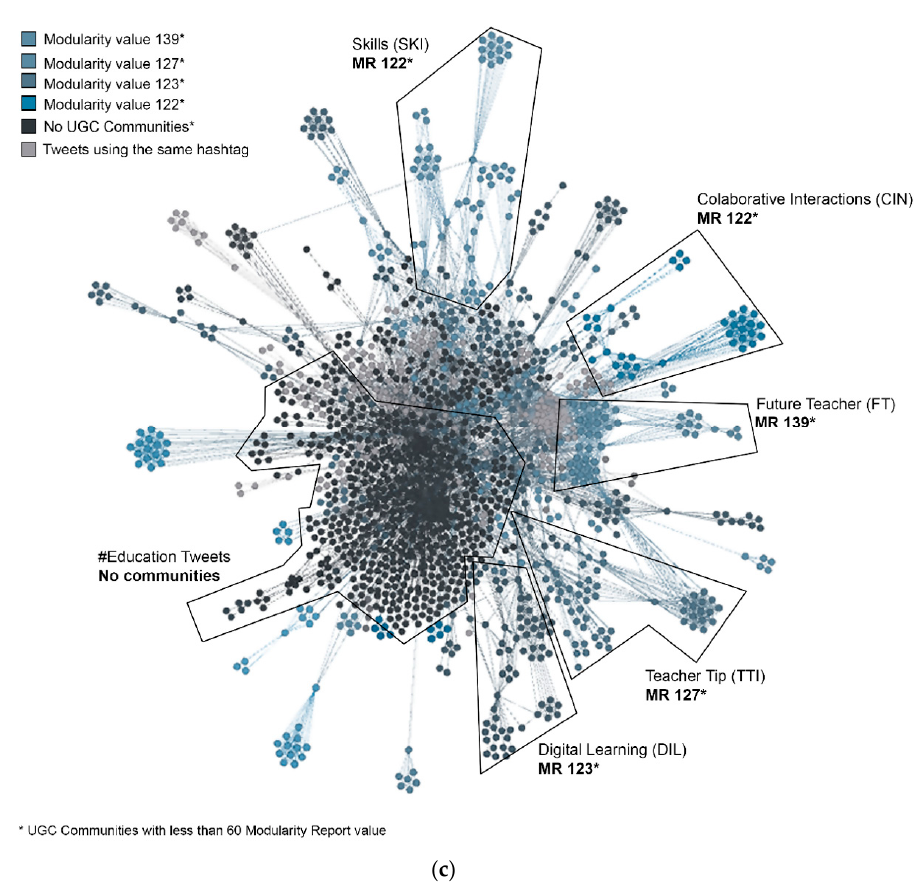
Figure 4. ( a ) Communities visualization resolution 1 ( b ) Modularity report communities visualization resolution 2 ( c ) Modularity report communities visualization. Source: The authors .